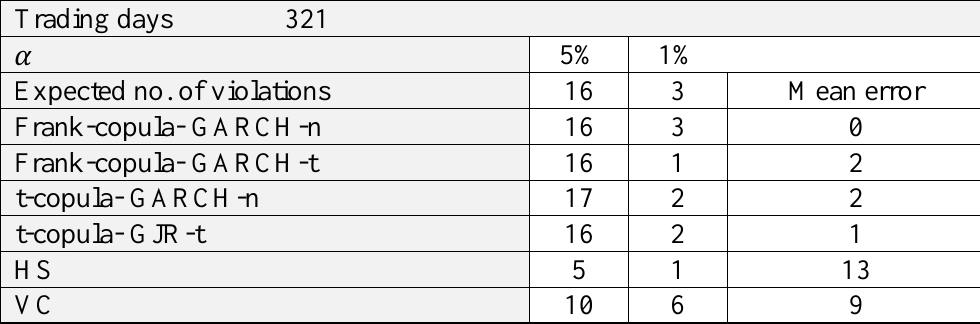
Table 6. Number of violations of VaR